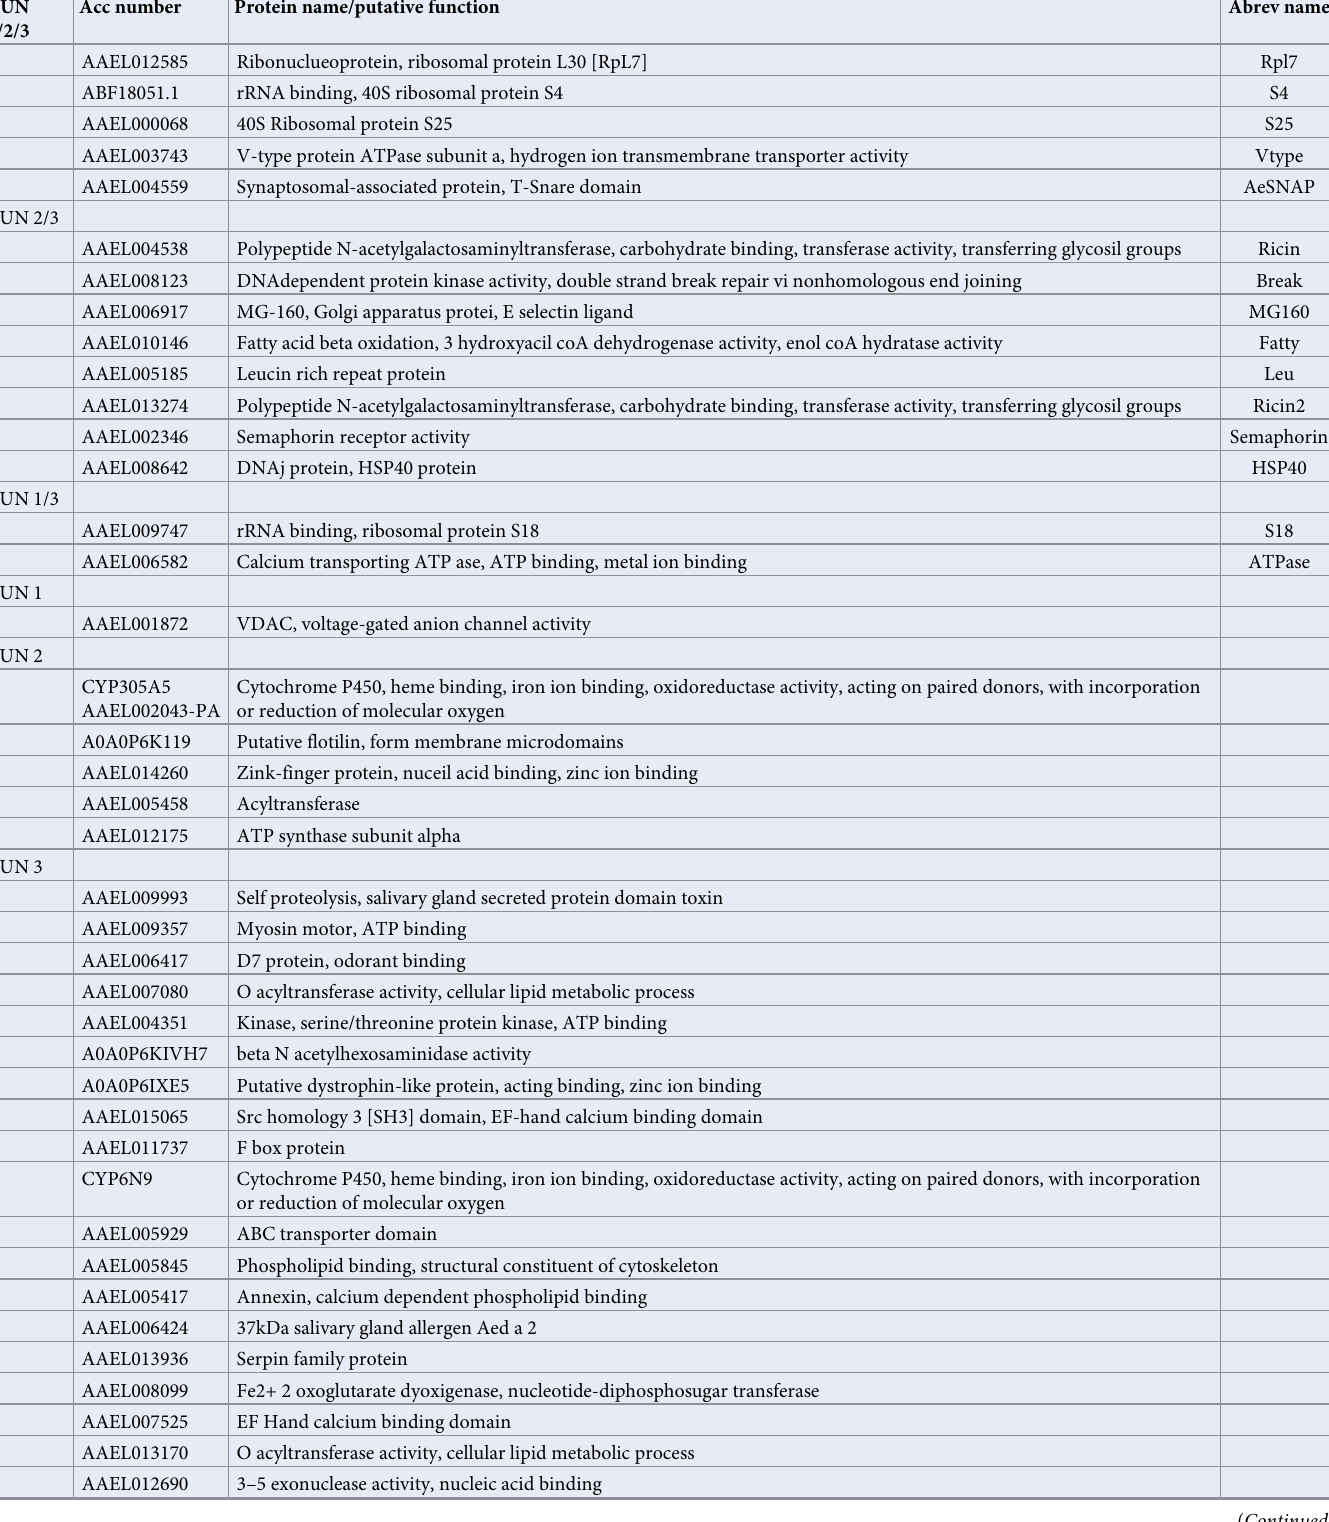
Table 1. List of putative DENV binders obtained from the A aegypti salivary gland extract by mass spectrometry assay. RUN